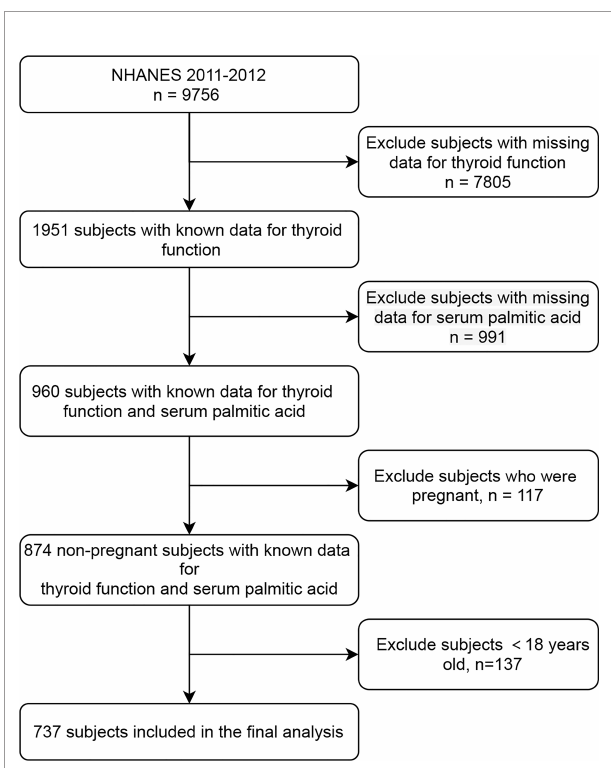
FIGURE 1 | Study fl owchart. NHANES, National Health and Nutrition Examination